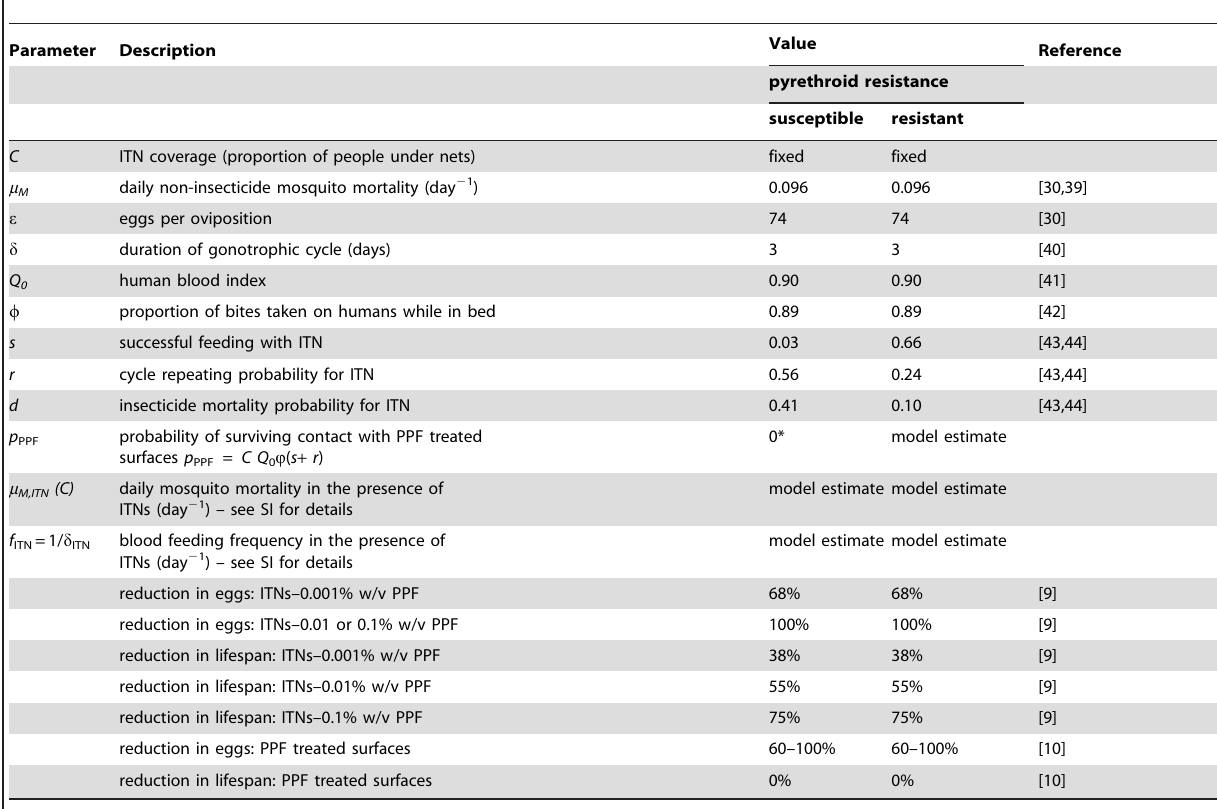
Table 1. Parameters for reproduction and interaction with pyrethroid/PPF co-treated surfaces.